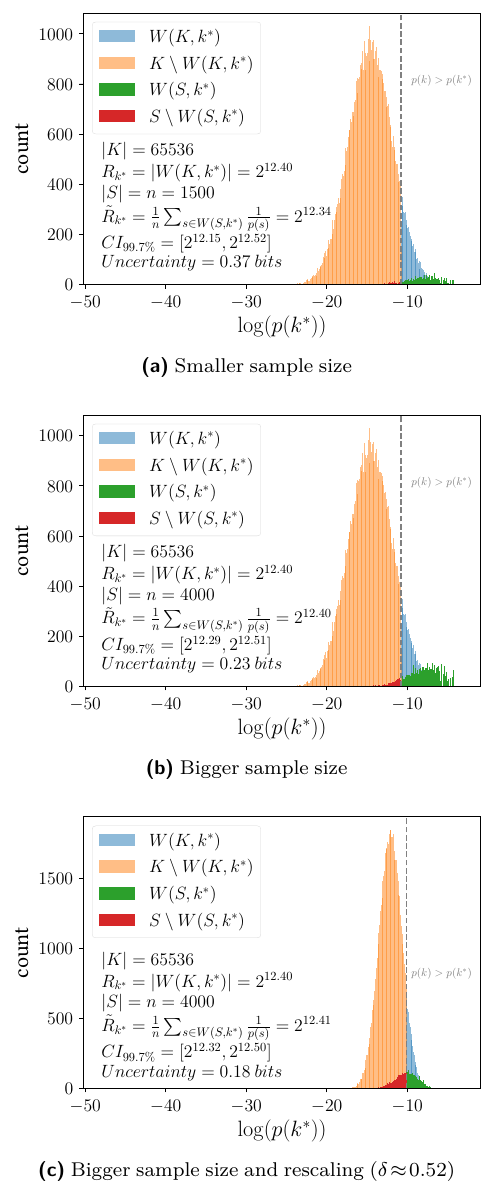
Figure 1: Visualization of the MCRank method for a 2-byte key toy example. MCRank computes an accurate estimate of the rank of the known key k ∗ from a small subset S of the keys K , sampled according to their probability. The non-uniform sampling strategy results in fewer low-probability keys in the sample. Increasing the sample size from 1,500 (a) to 4,000 (b) reduces the uncertainty. The input probabilities can be rescaled to ensure | W ( S,k ∗ ) |≈ | S \ W ( S,k ∗ ) | even if input probabilities were not balanced further reducing the uncertainty (c). Note that, no matter which rescaling we use for sampling, we are still computing the same rank.